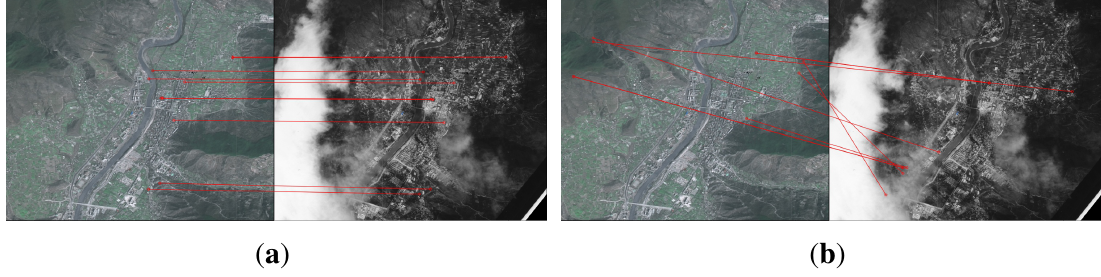
Figure 7. Matching result on a remote sensing image pair taken during the 2008 Sichuan earthquake (on a scale of 1:10,000) from the dataset ‘EOIR’. ( a ) The proposed method; ( b ) SIFT + RANSAC. The clouds appearing in the IR image do not generate incorrect matches for the proposed method, since they have been removed step by step in the cascade structure. SIFT + RANSAC barely generates a keypoint mapping due to the lack of texture in the cloud area (hence, fewer keypoints). The repeating structure of image content causes mismatches for SIFT +